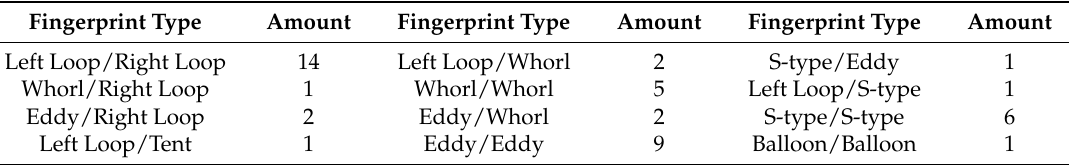
Table 4. Fingerprint types number summary and